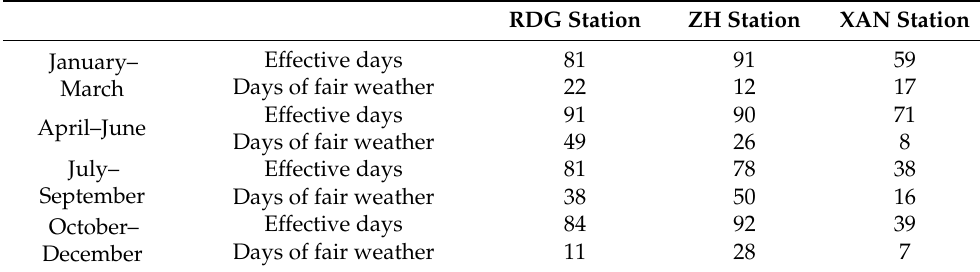
Table 3. Statistics of effective days and fair-weather days at the three